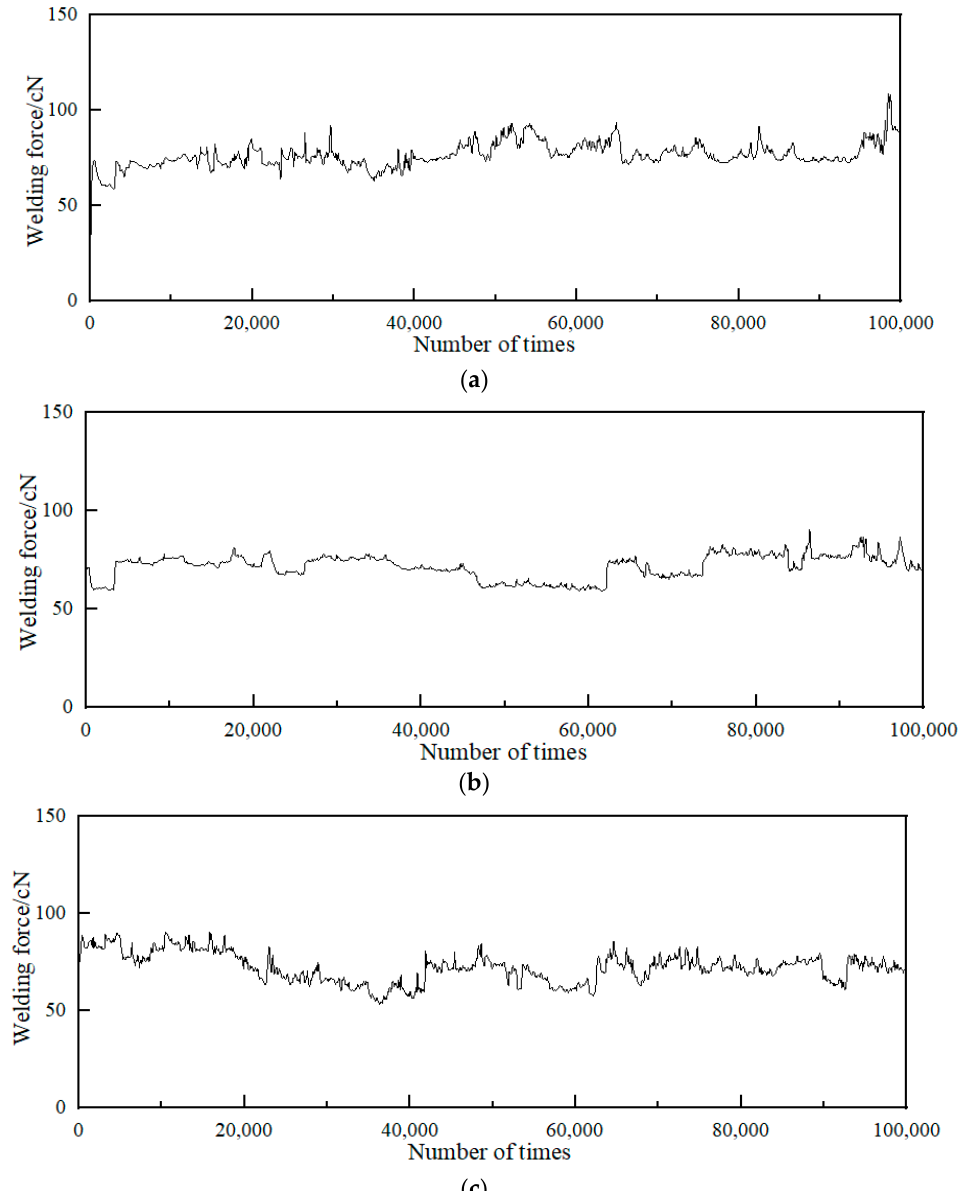
Figure 5. Welding force: ( a ) Ag/Ni, ( b ) Ag/Ni-Cu, and ( c ) Ag/Ni-C. From the welding force curve of undoped Ag/Ni in Figure 5a, it can be seen that the welding force of undoped Ag/Ni fluctuated considerably on the whole. There was an abrupt change at the 20,000th and 25,000th times, where the welding force dropped sharply from 75 to 45 cN, then rose to 85 cN at the 30,000th time, and then dropped to about 70 cN. Then it increased, and there was still a large degree of abrupt change at the 50,000th, 65,000th, and 98,000th times. The welding force of undoped Ag/Ni fluctuated obviously, and the stability was poor. Figure 5b,c are the welding force curves of Cu- and C-doped Ag/Ni. Compared with undoped Ag/Ni, the welding force decreased, and the curve after Cu doping became relatively flatter with less abrupt changes and more stable overall. After C-doping Ag/Ni, the welding force was relatively large in the early stage of the experiment, and it was unstable compared with Cu doping. In the later stage of the experiment, C doping showed a better result than Cu doping, which was consistent with the trend of arc energy. The doping elements can reduce the welding force of Ag/Ni and improve the welding resistance of Ag/Ni